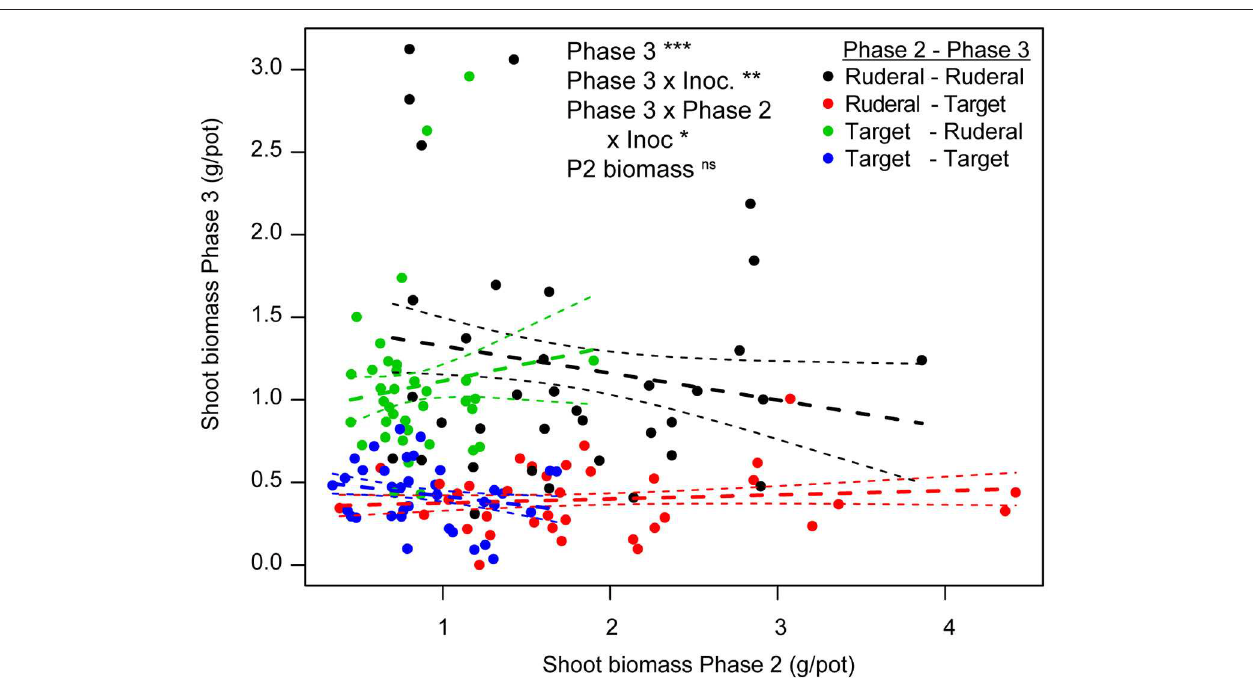
Frontiers in Ecology and Evolution | www.frontiersin.org